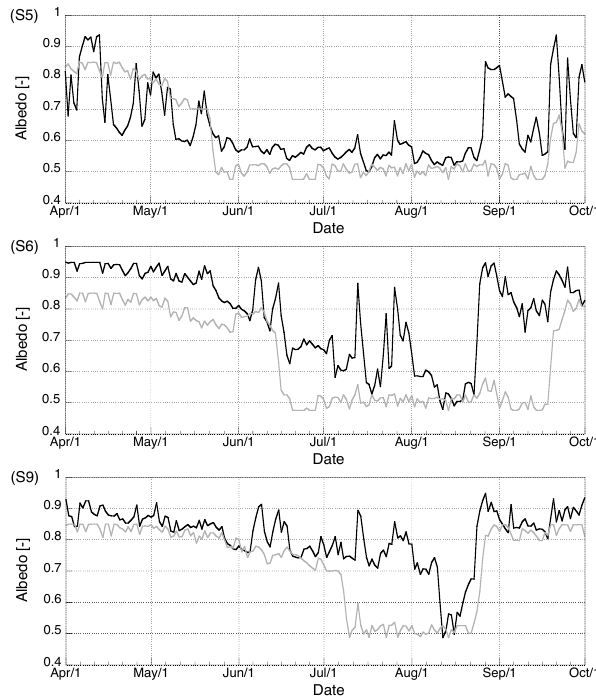
Fig. 10. Time evolution of the daily surface albedo [ − ] in the ob- servations (black lines) and model output (gray lines) for the three AWSs (S5, S6 and S9) along the K-transect for the period April– October